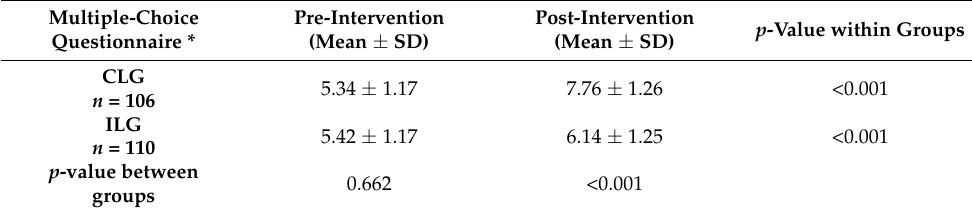
Table 2. Knowledge of professional ethics before and after the teaching programs for both groups.